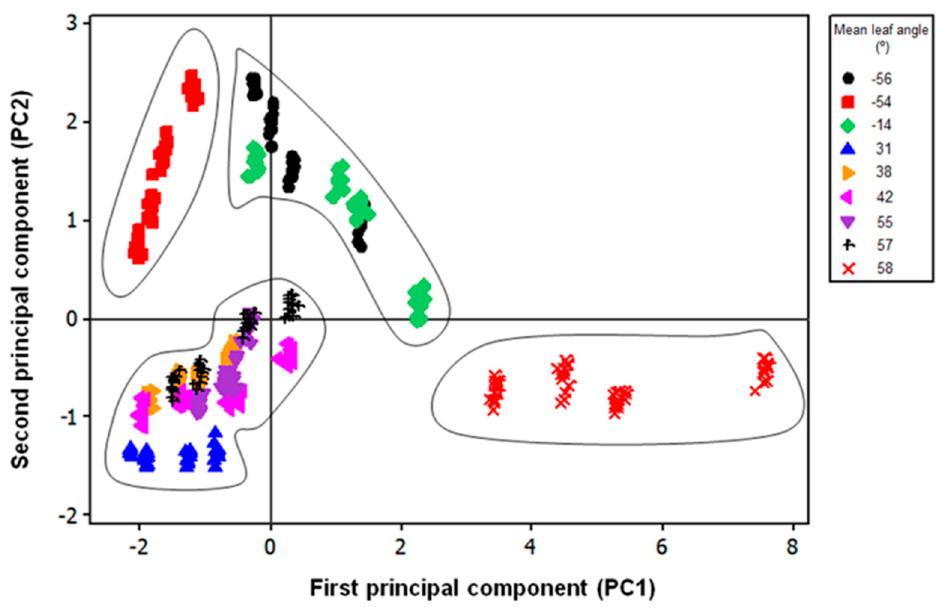
Figure 2. Representation of the first two principal components (PC1 and PC2) according to the treatments. Table 1. Effect of interaction between mean leaf angle and irrigation volume on leaching fraction (%) of seedlings (mean ± standard deviation).